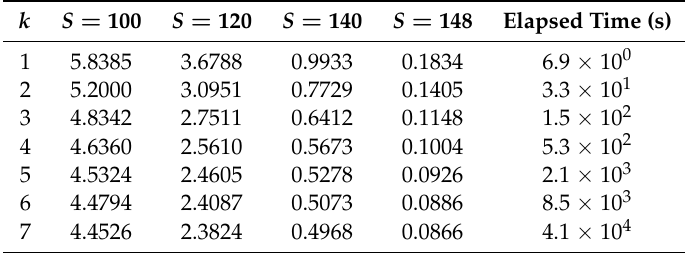
Table 3. V ( S ,0,0 ) evaluated by FD1at S = 100,120,140,148, with ∆ S = 2.